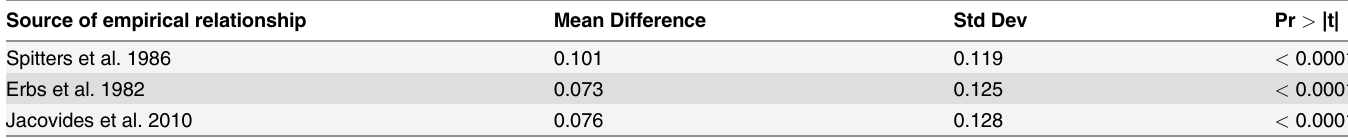
fraction of the measured data were collected when k values were in a range of 0.5 and 0.85, t meaning that differences between the three empirical relationships studied and measured data values greatly affected the overall model agreement. This is most apparent in this range of k t with the approach of Jacovides et al. [12] (Fig. 5), where many of the initial predicted values fit the measured data well, but the overall fit of the model was the worst of the three approaches. Table 5. Statistical analysis of the average difference between empirically derived diffuse percentages and measured